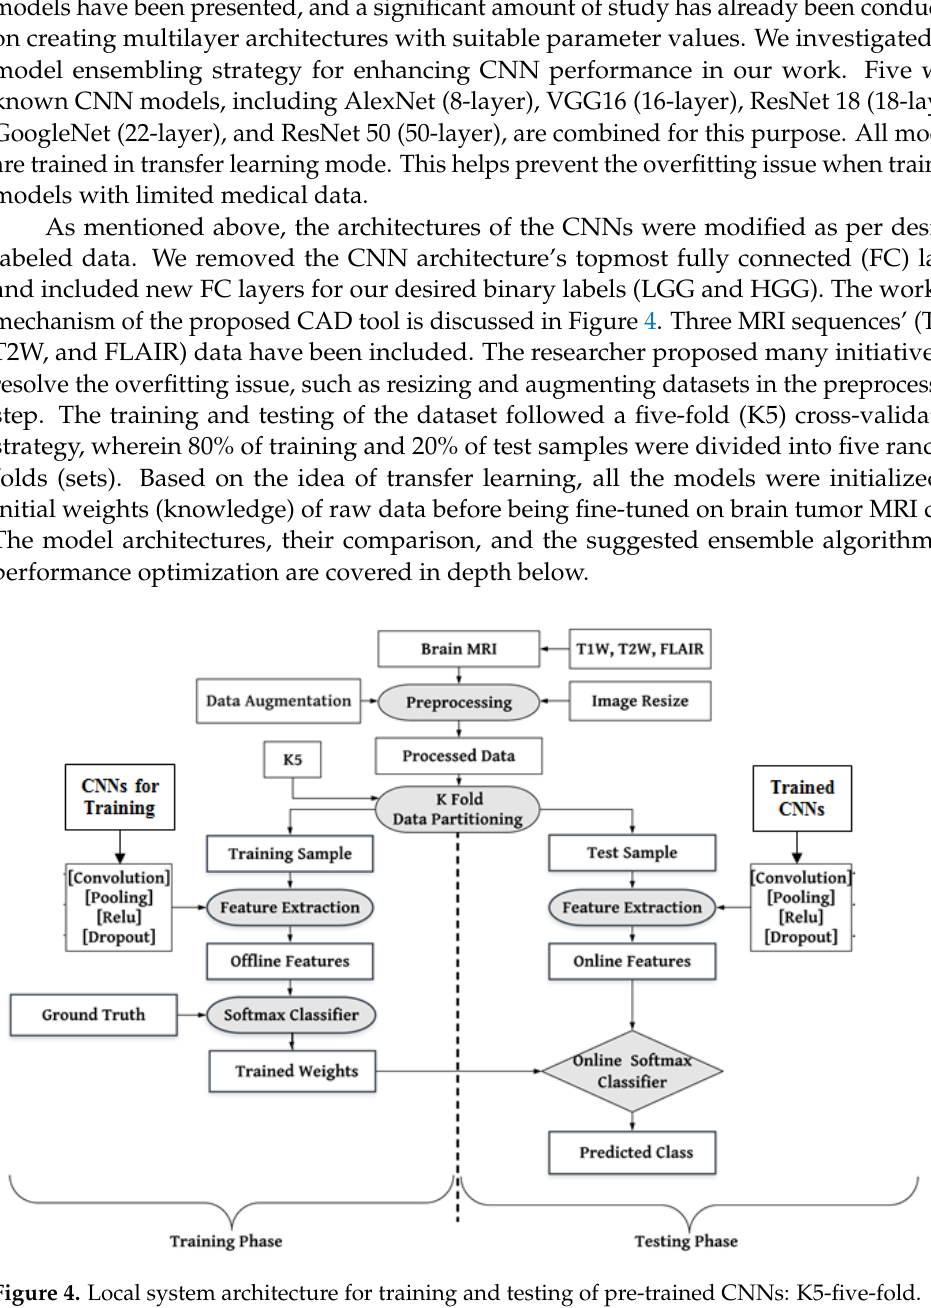
Figure 4. Local system architecture for training and testing of pre-trained CNNs: K5-five-fold.